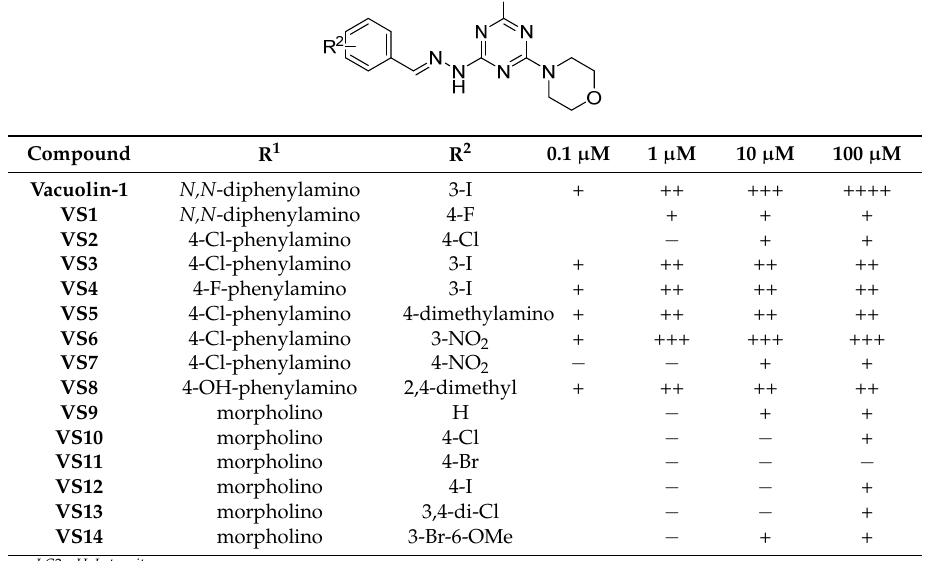
7 < λ / λ 0 ≤ 10; “++++”: 10 < λ / λ 0 . “++++”: 10 < λ / λ 0 .